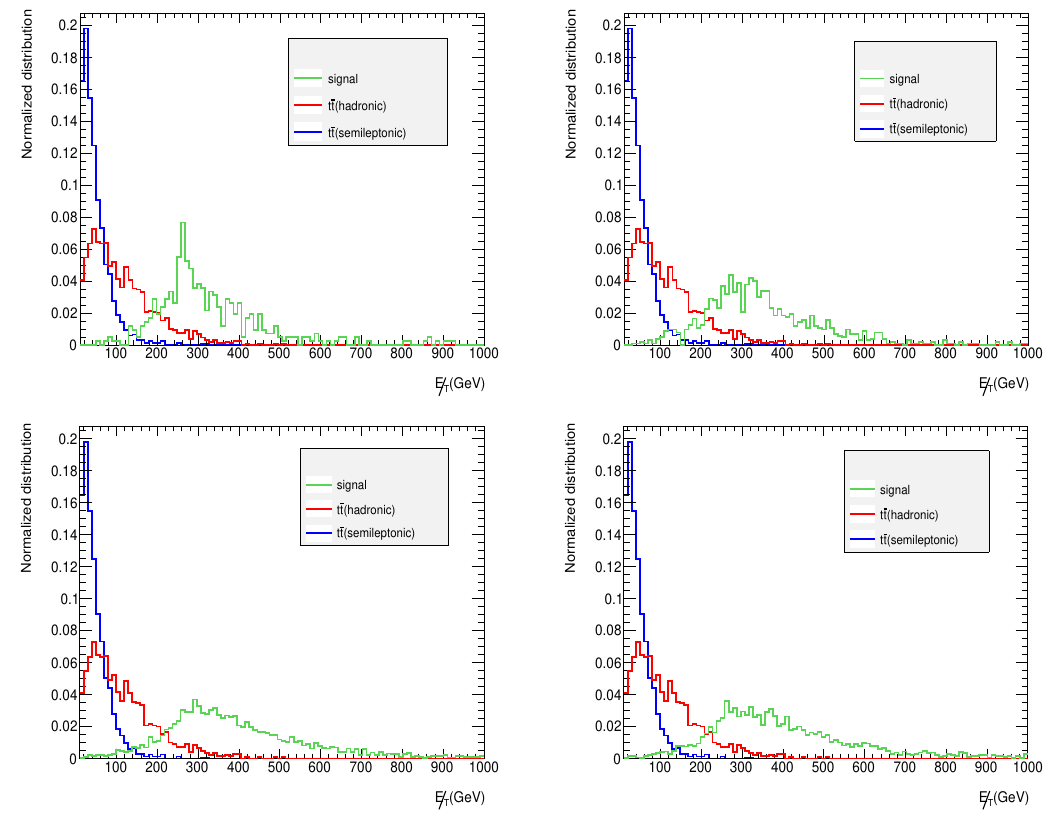
Figure 7 . =E T distribution for gluon fusion signal and background processes, Type I BP I(top left), Type I BP II(top right), Type II BP I(bottom left) and Type II BP II(bottom right). TypeI BP I TypeI BP II TypeII BP I TypeII BP II Z ( (cid:23) (cid:22) (cid:23) )+ j W ( l(cid:23) )+ j t (cid:22) t hadronic t (cid:22) t semileptonic